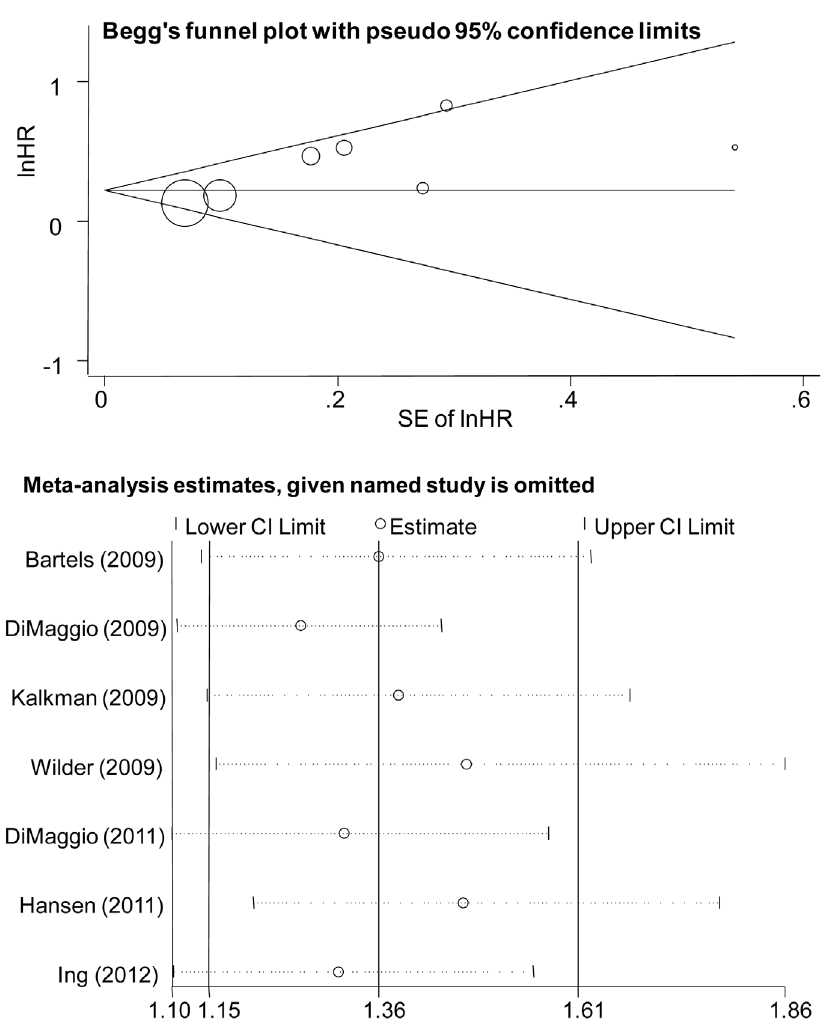
Figure 3. Publication bias and influence analysis of meta-analysis. A. Funnel plots of studies included in the meta-analysis. The vertical axis represents ln[HR] and the horizontal axis means the standard error of ln[HR]. Horizontal line and sloping lines in funnel plot represent summary HR and expected 95% CIs for a given standard error, respectively. Area of each circle represents contribution of the study to the pooled OR. B. Influence of individual studies on the pooled HR. The vertical axis indicates the overall HR and the two vertical axes indicate its 95% CI. Every hollow round indicates the pooled OR when the left study is omitted in this meta-analysis. The two ends of every broken line represent the respective 95% CI.